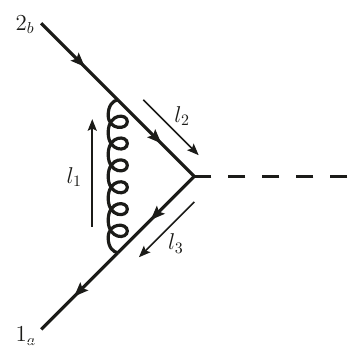
Figure 2 . Feynman diagram for one-loop contribution to the coupling between a massive fermion pair and an off-shell scalar. All external momenta are